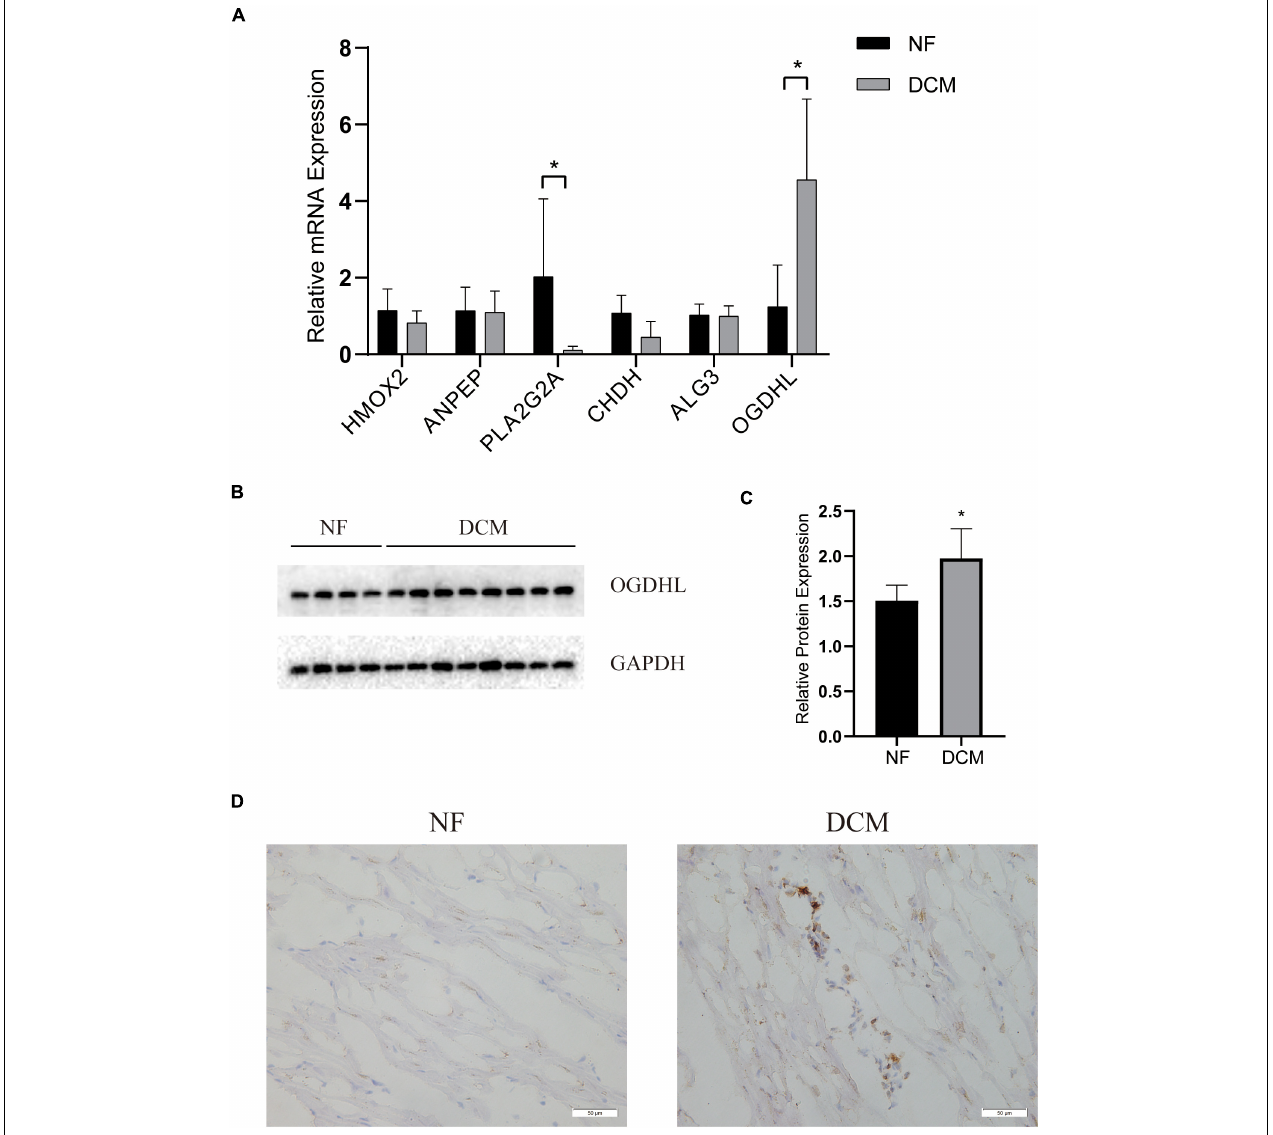
FIGURE 5 | The validation of key genes expression in human hearts. (A) The mRNA levels of the key genes expression and (B,C) the protein levels of OGDHL expression in left ventricular tissues of patients with DCM and NF donors. (D) Representative OGDHL immunohistochemistry images of heart sections from patients with DCM and NF donors (magnification 400 × ). * P < 0.05 vs. NF. n =